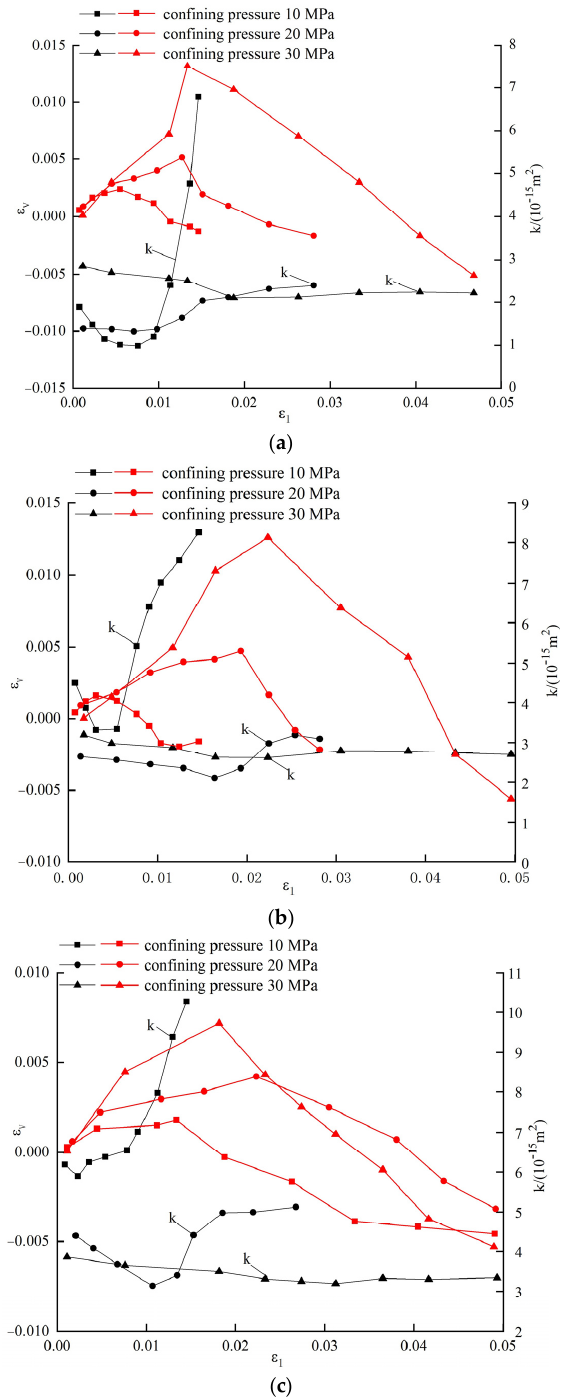
Figure 9. Volumetric strain, axial strain and permeability, axial strain of sandstone under different seepage pressures, ( a ) Pore pressure 1 MPa; ( b ) pore pressure 4 MPa; ( c ) pore pressure 7 MPa.